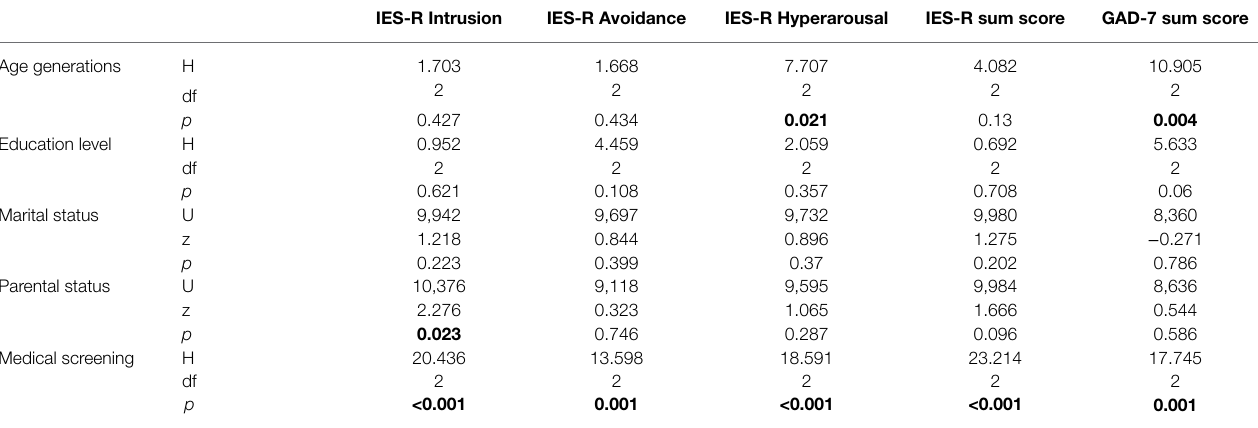
TABLE 3 | Values for the non-parametric